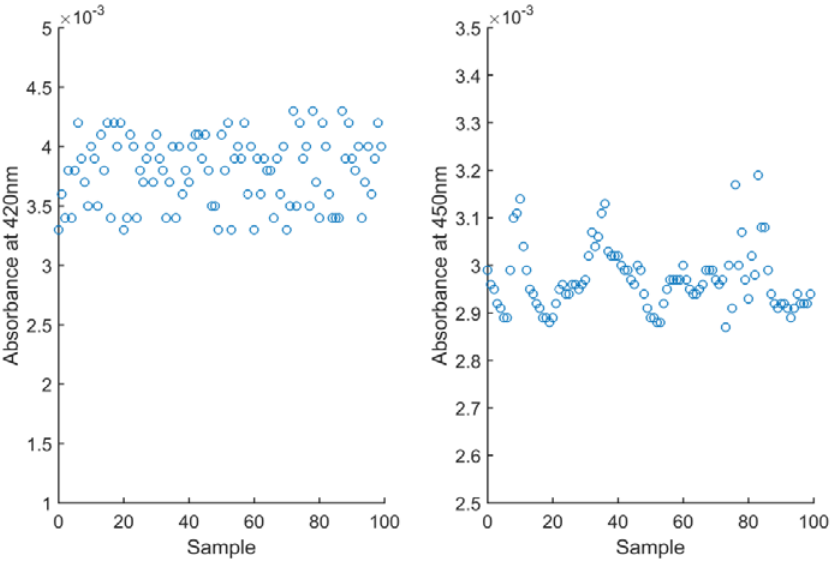
Figure 9. The absorbance of the blank working solution at 420 nm and 450 nm.